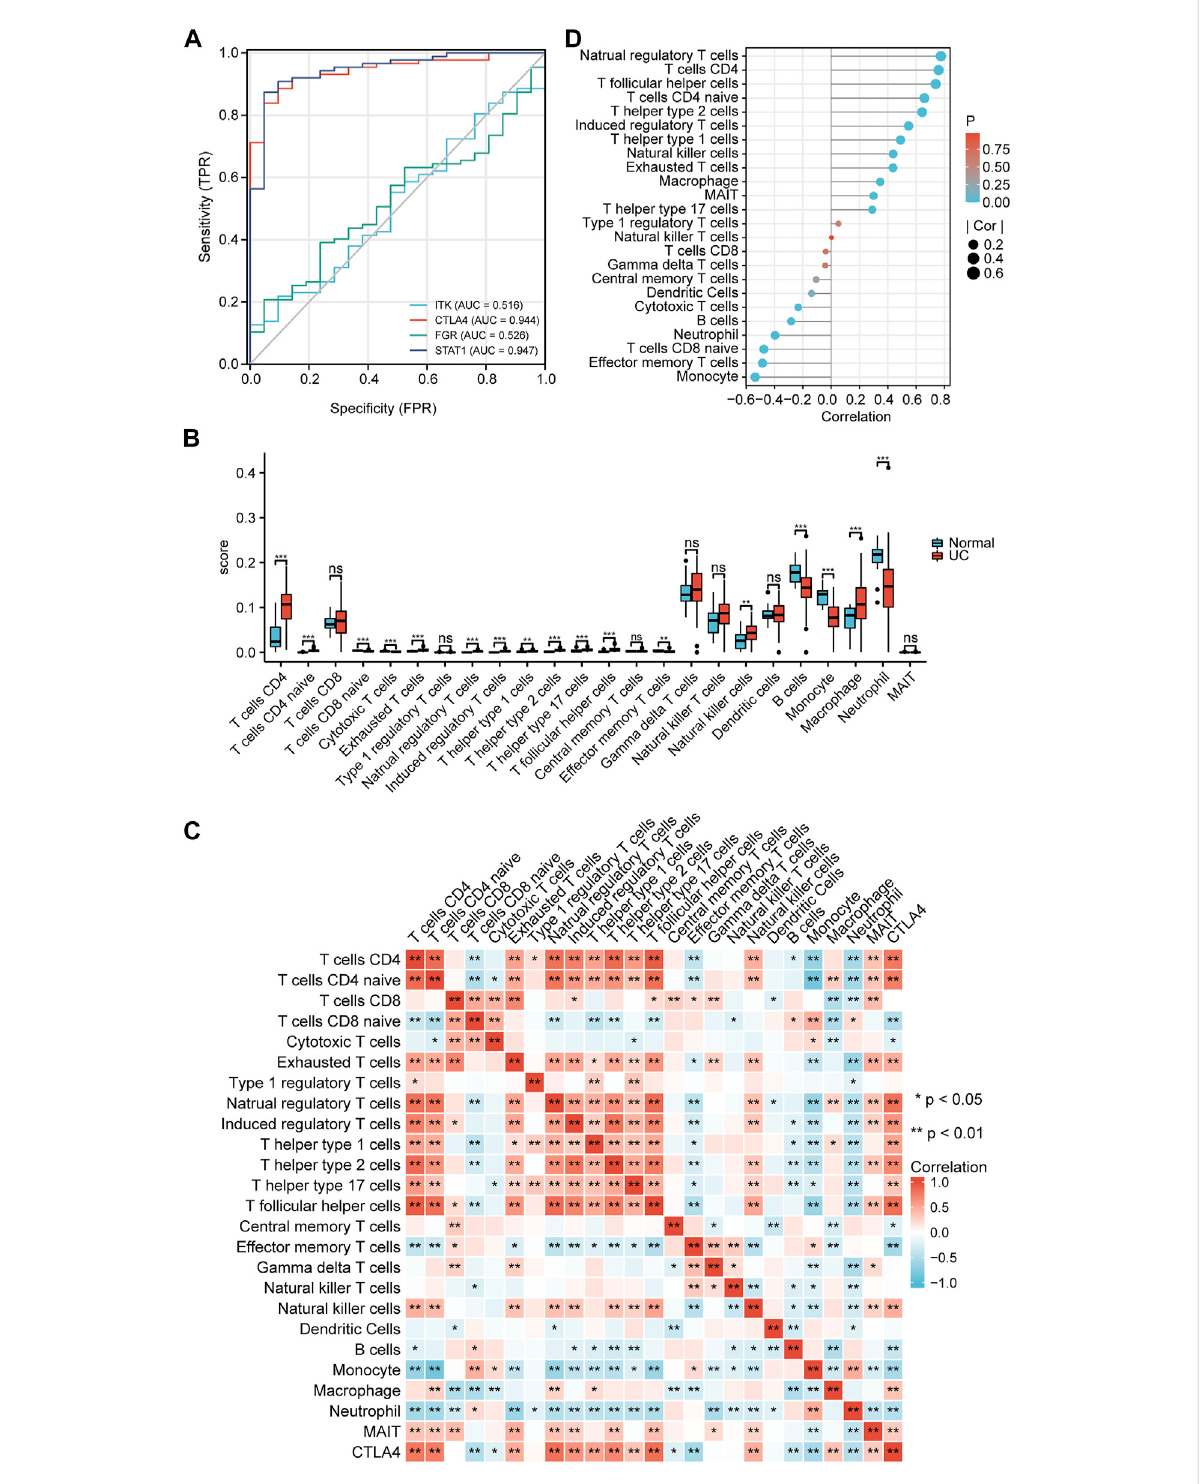
FIGURE 8 Validationandimmunein fi ltrationanalysis. (A) ROCofmRNAsintheceRNAnetwork. (B) The differentialofimmune in fi ltrationbetween theUC and normal groups. (C) Correlation matrix of immune cell proportions and CTLA4 . (D) Lollipop chart of the correlation between immune cells and CTLA4 . * p < 0.05, ** p <